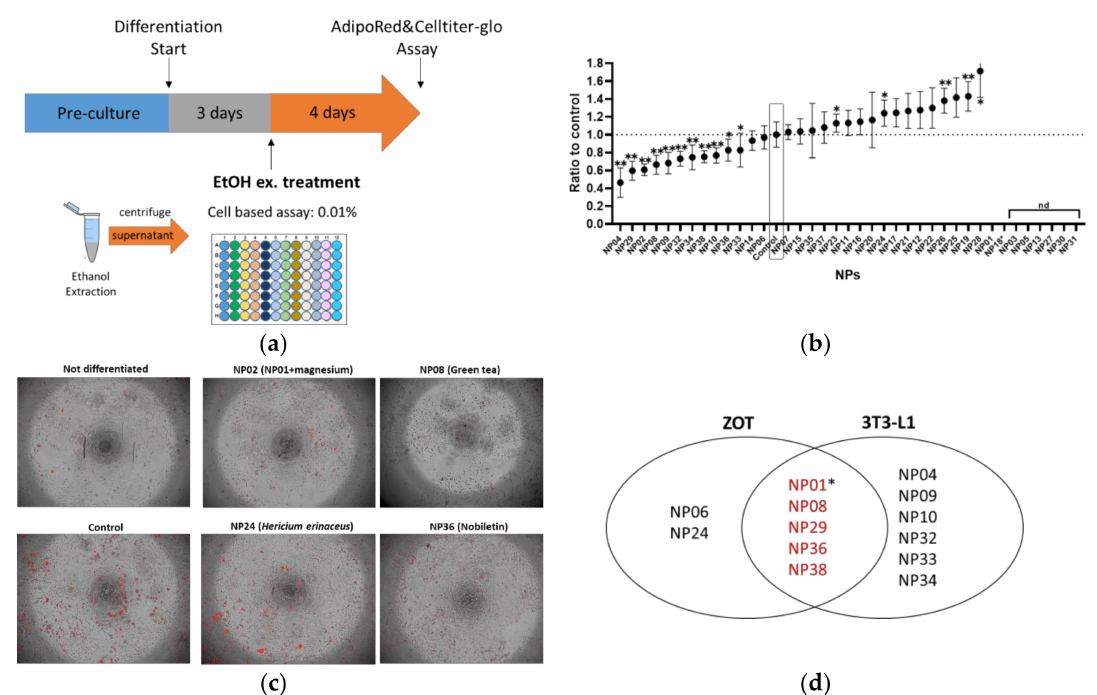
Figure 2. Mouse 3T3-L1 preadipocyte di ff erentiation assay identified ten lipid-lowering NPs. ( a ) Experimental design for 3T3-L1 assay. ( b ) Result of 3T3-L1 screening. NPs without data